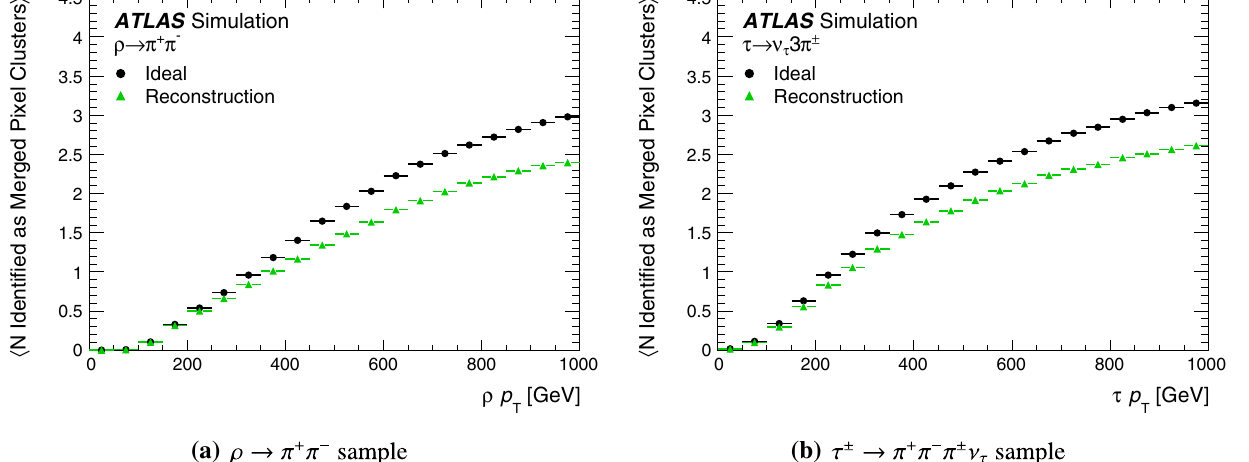
Fig. 9 A comparison of the average number of merged pixel clusters expected for truth particles from simulation and pixel clusters identi- fied as merged used in reconstructed tracks is shown as a function of the ρ and three-prong τ ( τ → π + π − π ± ν τ ) transverse momentum. Ideal